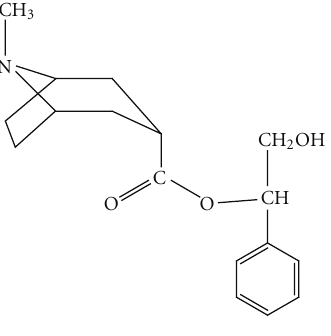
Figure 1: Structure of